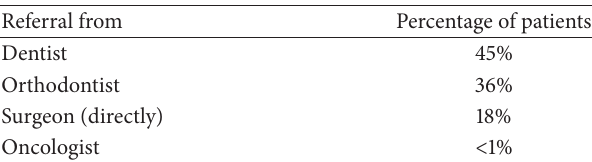
Table 1: Referral